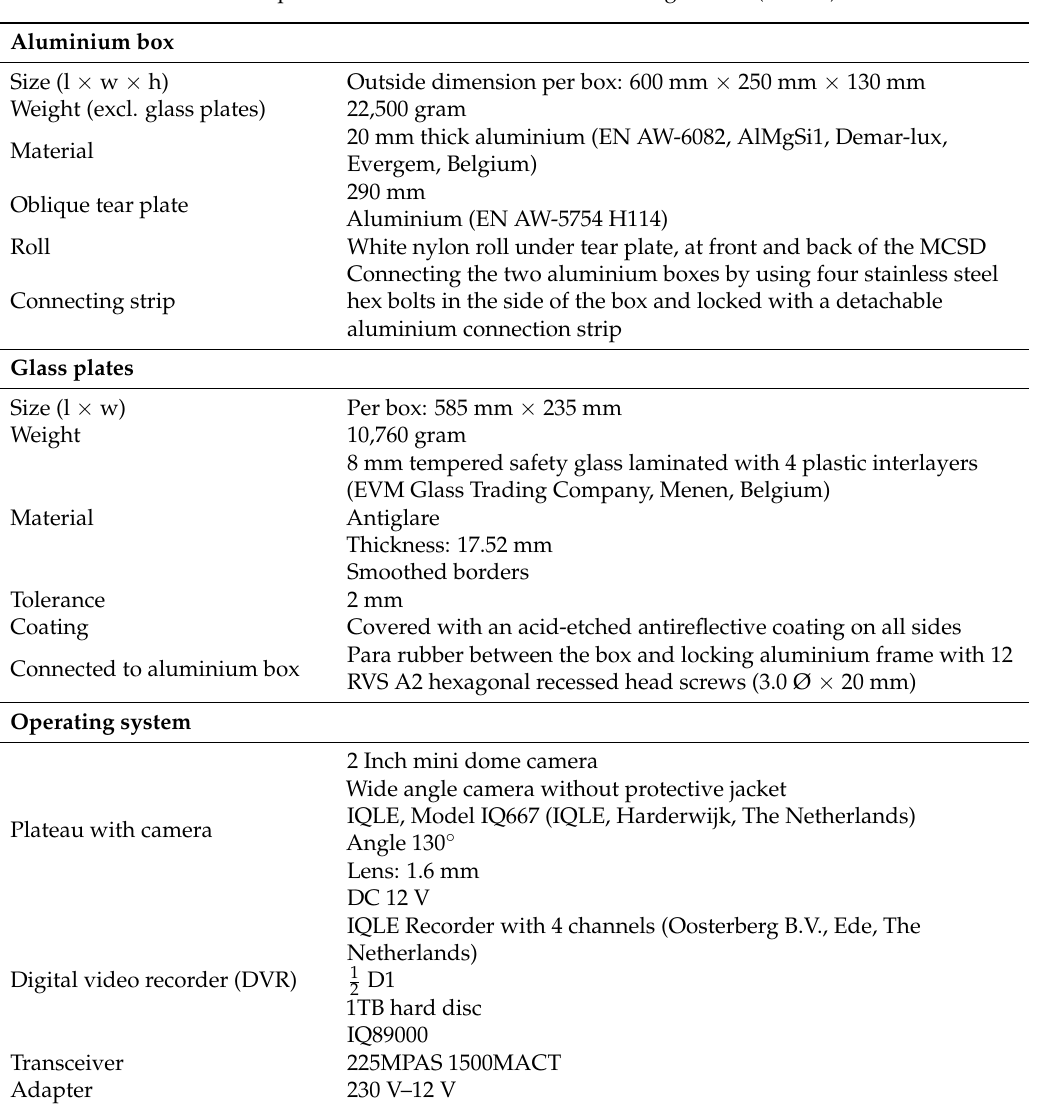
Table 1. Specifications of the Mobile Claw Scoring Device